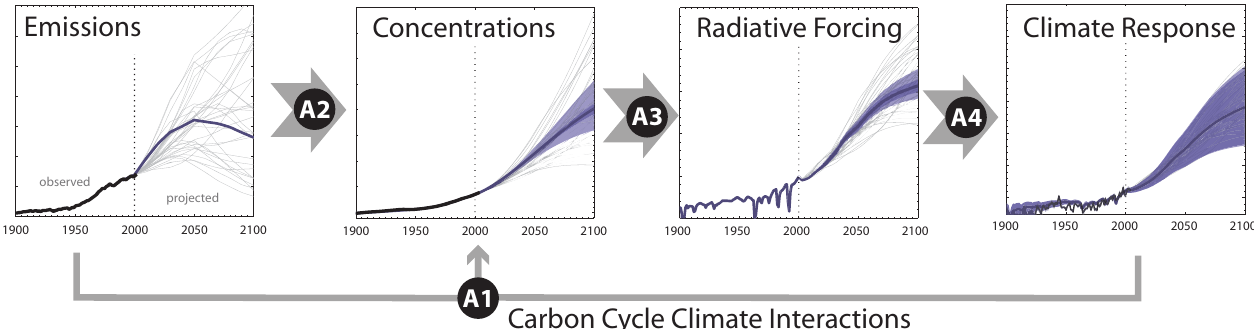
Fig. A1. Schematic overview of MAGICC calculations showing the key steps from emissions to global and hemispheric climate responses. Black circled numbers denote the sections in the Appendix describing the respective algorithms used.